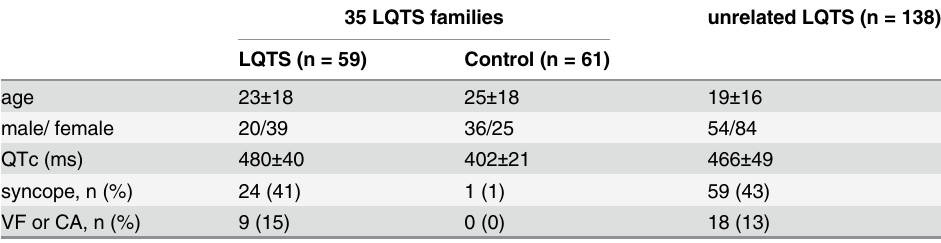
Table 2. Clinical background of LQTS patients and their family